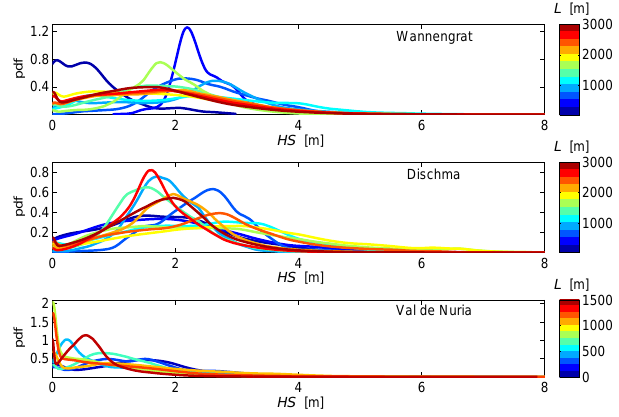
Figure 3. One example probability density function (pdf) of mea- sured snow depths HS for each domain size L (in color) in each